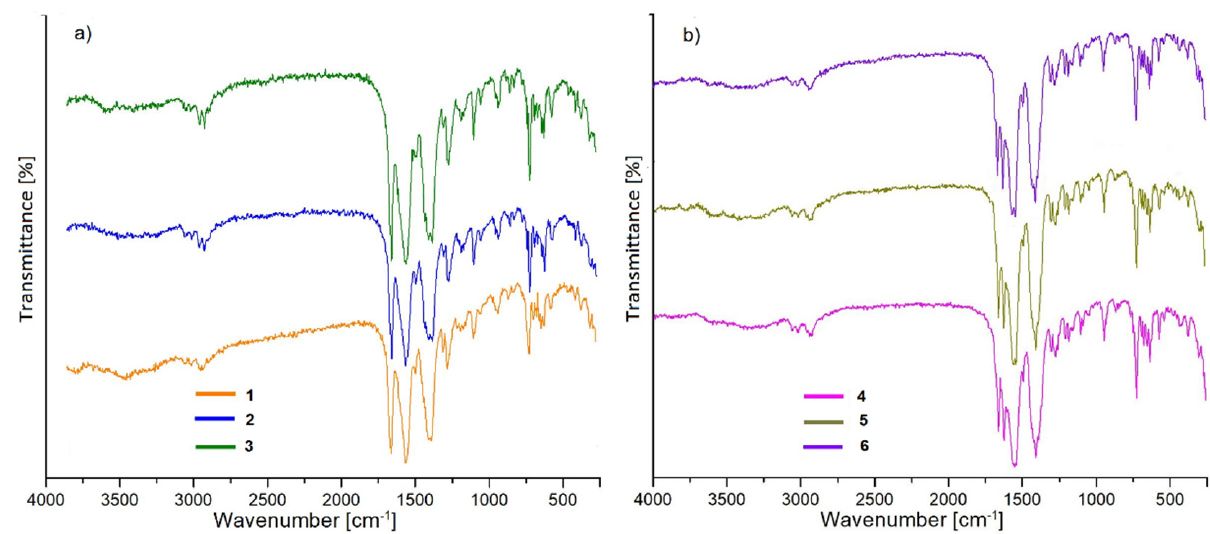
Figure 5. Infrared spectra of isostructural complexes: ( a ) 1 – 3 ; ( b ) 4 – 6 . The presence of DMF molecules in the structures of the complexes is also clearly reflected in the infrared spectra. The all spectra are characterized by relatively weak bands in the range number 3100–2800 cm − 1 , which correspond to the stretching vibrations of methylene groups from 1,2-phenylenediacete ligands and methylene groups from N , N (cid:48) - dimethylformamide molecules. In the first group of compounds (Pr, Sm, and Eu), stretching vibrations of carbonyl groups from DMF molecules coordinated to the lanthanide center give bands at 1660–1656 cm − 1